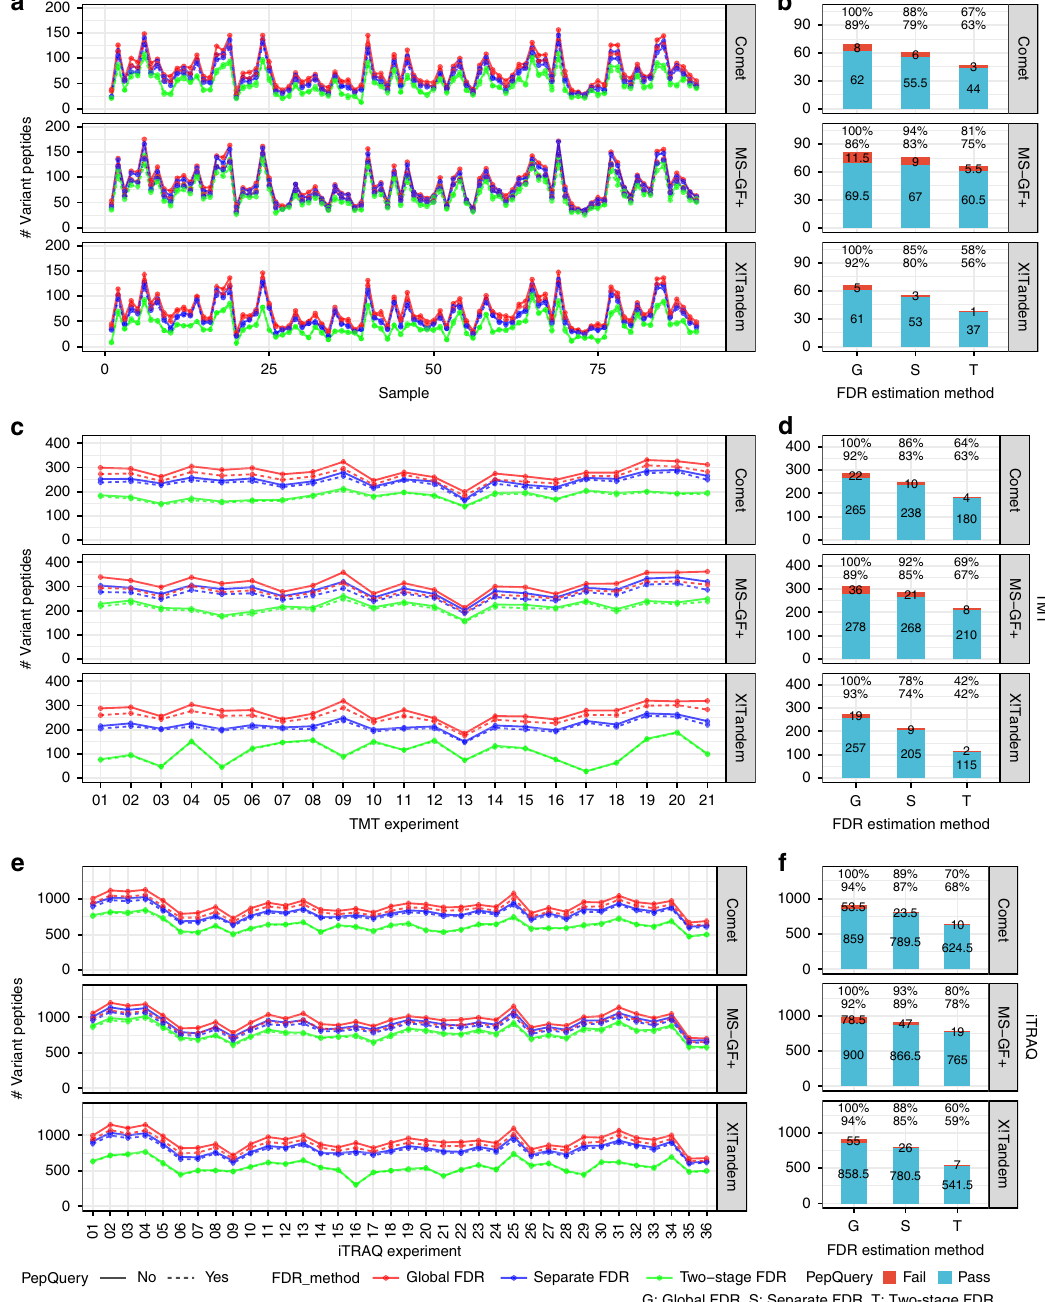
Fig. 3 Sensitivity of variant peptide identi fi cation. a Variant peptide identi fi cation for each label-free sample. b Median numbers of identi fi ed variant peptides in label-free samples. c Variant peptide identi fi cation for each TMT sample. d Median numbers of identi fi ed variant peptides in TMT samples. e Variant peptide identi fi cation for each iTRAQ sample. f Median numbers of identi fi ed variant peptides in iTRAQ samples. The percentage numbers above the bars in the bar plots are the ratios compared with the most sensitive methods in each plot. The numbers on the bars are the numbers of variant peptides. Source data are provided as a Source Data fi le. Solid lines indicate the identi fi ed variant peptides without fi ltering using PepQuery and dashed lines indicate the identi fi ed variant peptides passed PepQuery